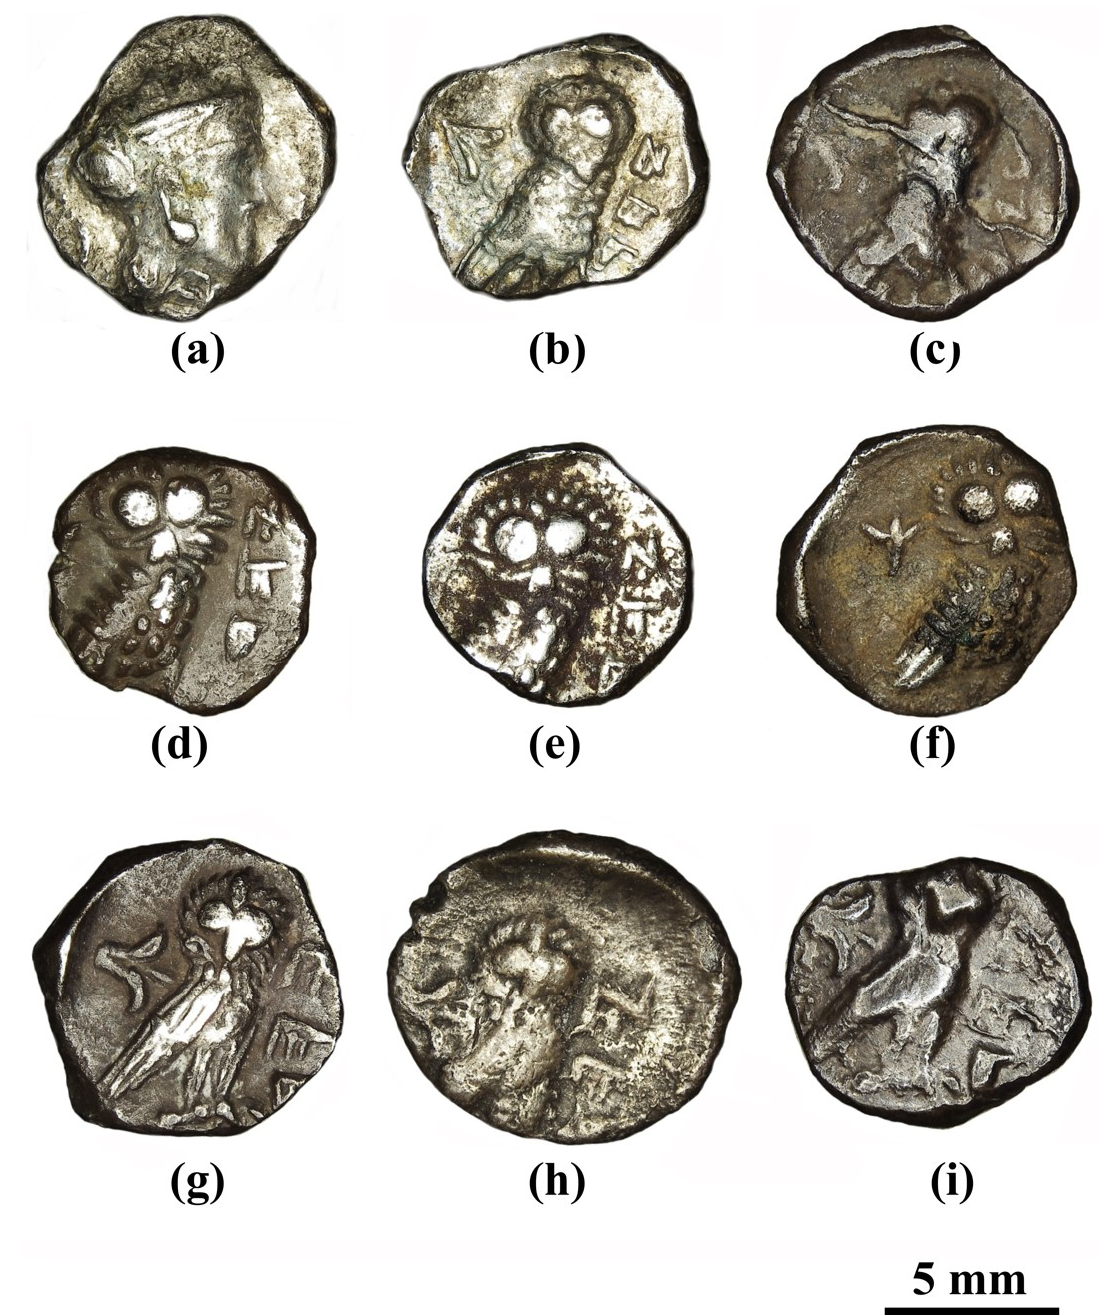
Figure 3. Multi-focal light microscope (LM) enlarged observation of the Yehud gerah coins Type 5 die-linked connection, with the same obverse (O1) but different reverses (R1, R2, and R4): ( a ) O1/R1: IAA 138139 (Khirbat Qeiyafa excavations), obverse, showing the helmeted head of Athena; ( b ) O1/R1: IAA 138139, reverse, showing a lily, symbol of Jerusalem (left), owl (center), and Aramaic inscription of Judea (YHD, right); ( c ) O1/R1: IMJ 34542, reverse; ( d ) O1/R2: IMJ 34537, reverse; ( e ) O1/R2: IAA 154383 (Khirbat Qeiyafa); ( f ) O1/R2: IMJ 34538, reverse; ( g ) O1/R4: Ramallah area hoard no. 1, IMJ 2006.53.26139 (RH2), reverse; ( h ) O1/R4: Ramallah area hoard no. 5, IMJ 2006.53.26142 (RH5), reverse; and ( i ) O1/R4: IMJ 34556, reverse.